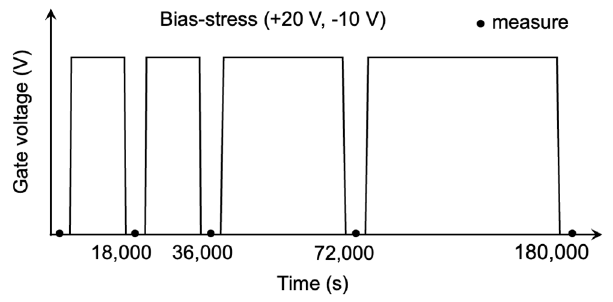
Figure 4. Time sequence for gate stress and threshold voltage measurement.